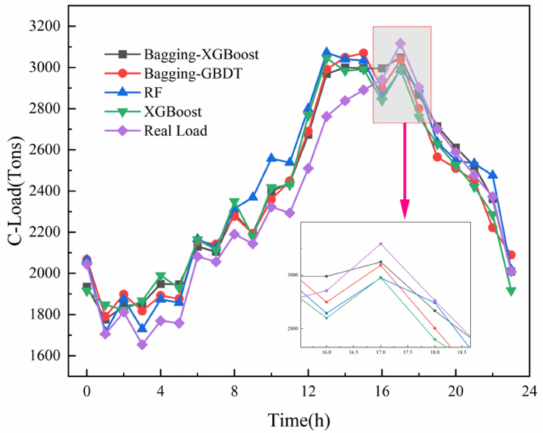
Figure 15. Cooling load forecast results.